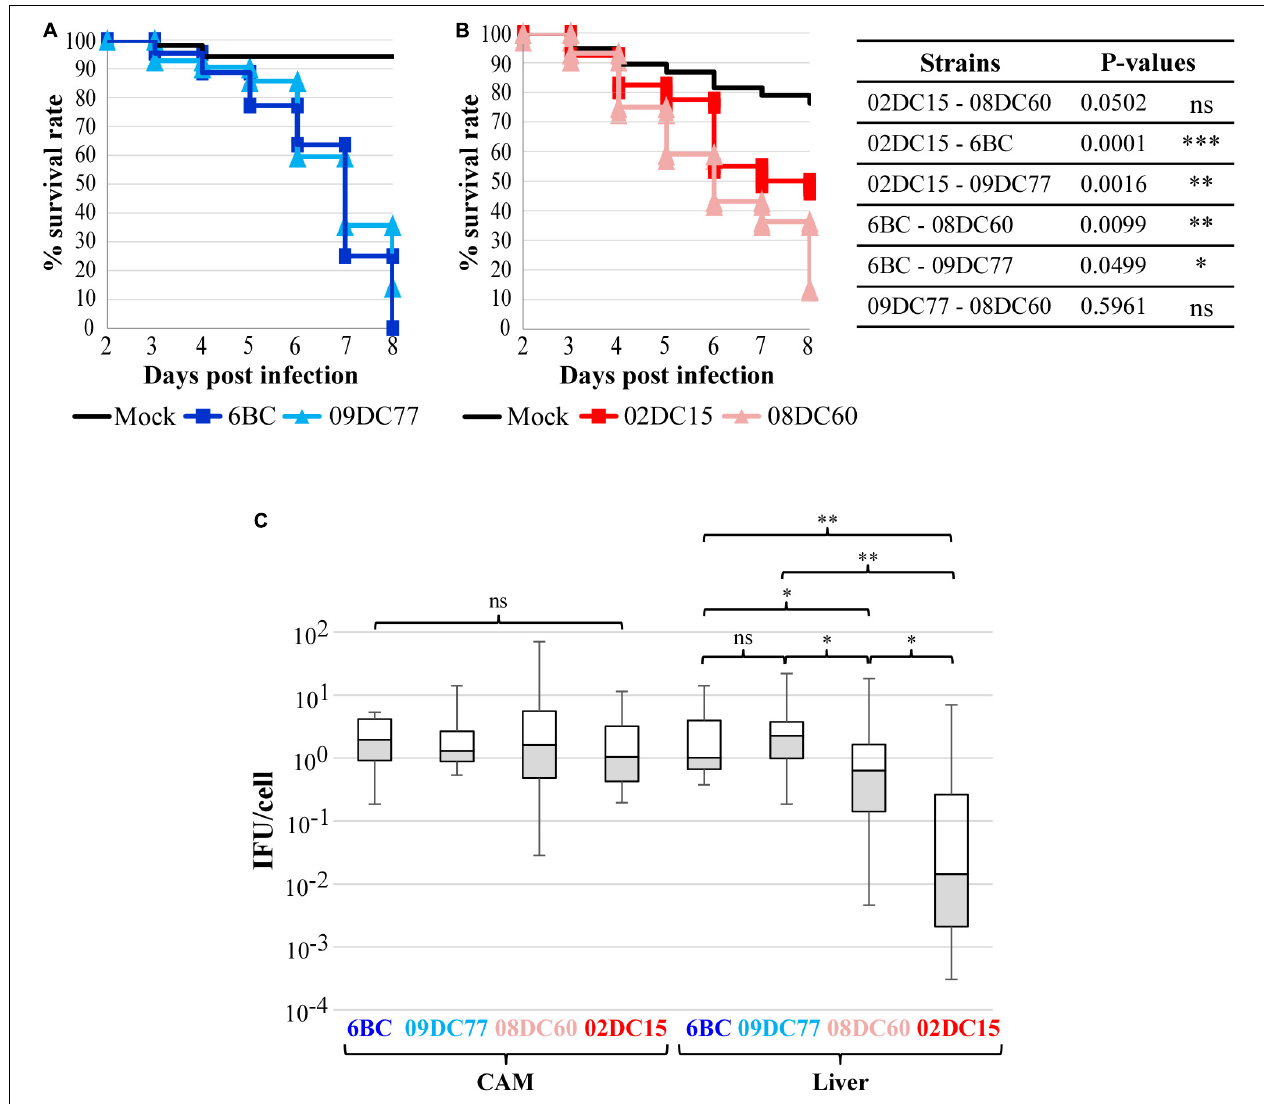
FIGURE 1 | Avian C . psittaci strains have a higher virulence in chicken embryos than mammalian C. psittaci strains. (A,B) Kaplan–Meier survival curves of chicken embryos challenged with C. psittaci strains. Embryonated eggs were infected with 5*10 4 IFU/egg on developmental day 10 and their survival was recorded for 8 days. (A) Survival curves of eggs infected with avian C. psittaci strains 6BC ( n = 44), 09DC77 ( n = 42) and mock ( n = 52). (B) Survival curves of eggs infected with mammalian C. psittaci strains 02DC15 ( n = 40), 08DC60 ( n = 44) and mock ( n = 38). P-values were calculated using Chi-square tests at day 8, to highlight the different virulence of the strains at the end of the infection. * p < 0.05, ** p < 0.01, *** p < 0.001 (C) Dissemination of C. psittaci strains in the CAM and liver of infected embryonated eggs at the end of the experiment. C. psittaci genomic DNA was quantified by specific real-time PCR and normalized to the number of chicken cells. The amount of C. psittaci in CAM and liver is displayed in boxplots. P-values were calculated using Mann–Whitney U test. * p < 0.05, ** p <